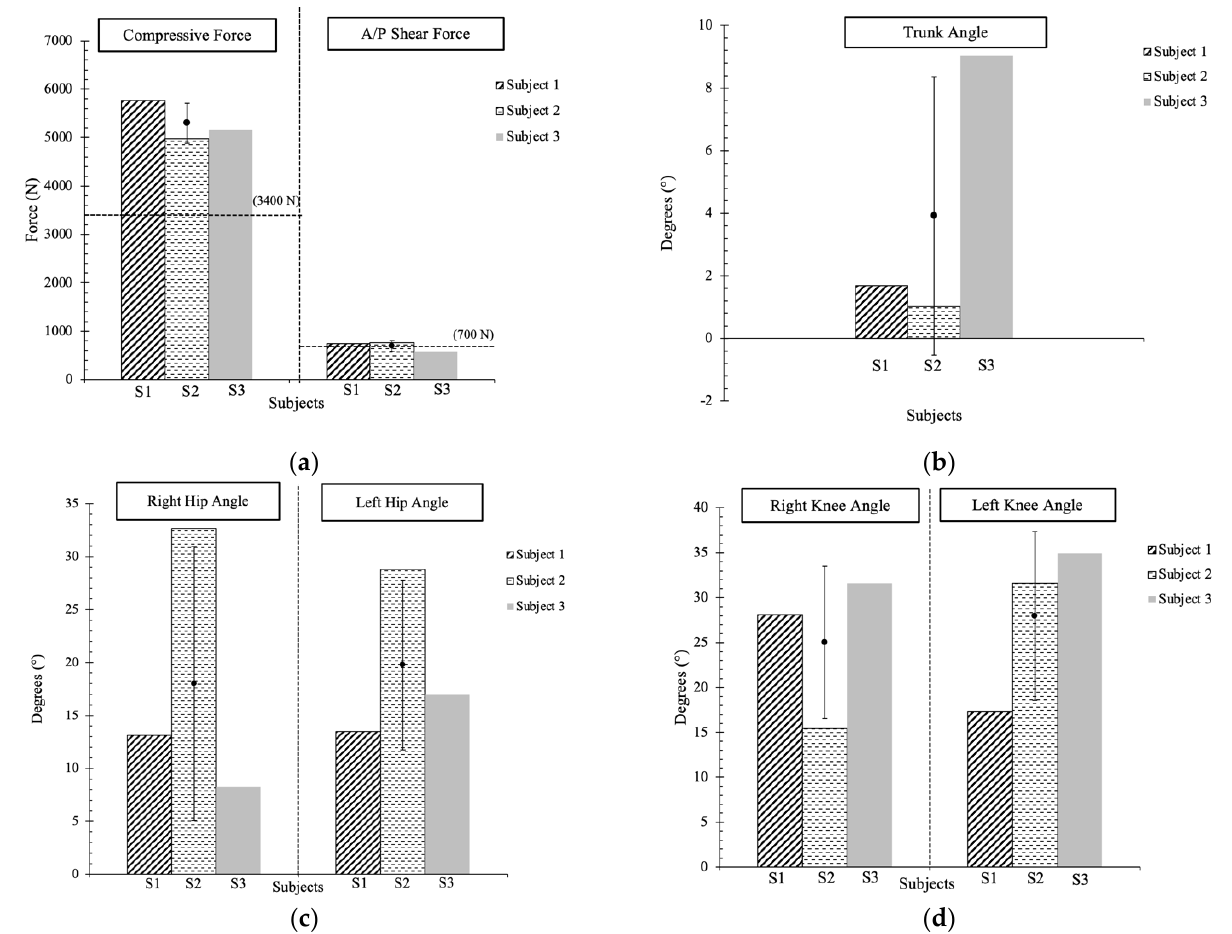
Figure 8. The analyzed results at Pose#2 in Task#2: ( a ) the exposed spinal forces with the recom- mended safety threshold values; ( b ) the trunk angles; ( c ) the hip angles; ( d ) the knee angles.